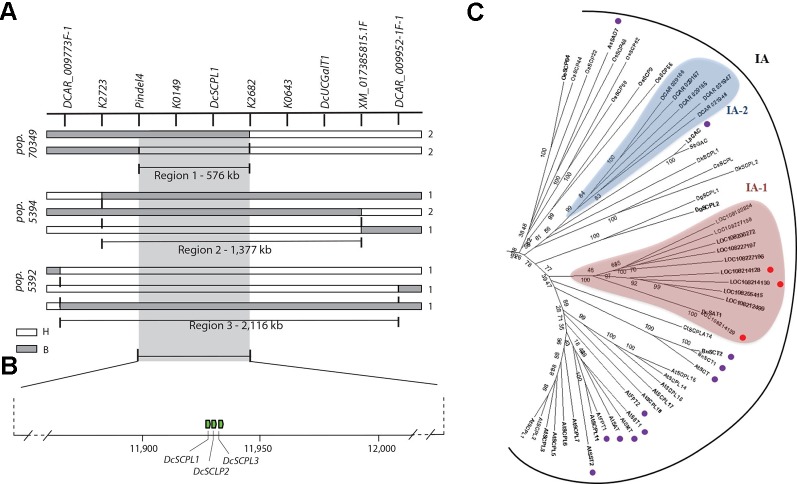
Fine mapping summary and phylogenetic analysis of candidate genes controlling the Raa1 locus. (A) Haplotypes delimiting the genomic regions controlling the Raa1 locus in population 70349 (region 1), 5394 (region 2), and 5392 (regions 3). Genotyping scores to draw this figure were extracted from
Supplementary Table S11
. The white bars indicate the heterozygous haplotypes (H = Aa) and the gray bars indicate the homozygous recessive haplotypes (B = aa). Region 1 represent the genomic sequence delimited by the nearest markers flanking the Raa1 locus across regions 1–3. Numbers on the right side of each bar represent the number of recombinant genotypes for each haplotype. (B) Schematic representation of carrot chromosome 3 containing regions 1–3 and three SCPL acyltransferase genes (green boxes). The scheme was drawn to scale. (C) SCPL phylogenetic clade IA extracted from the neighbor-joining phylogenetic analysis of SCP and SCPL proteins presented in
Supplementary Figure S5
. Bootstrap values are percentage from 1,000 replicates. The scale bar indicates 0.1 substitutions per site. Clades are labeled according to Fraser et al. (2005). Two clusters of carrot SCPL-ATs are highlighted, IA-1 (red) and IA-2 (blue). Protein sequences and complementary information are presented in
Supplementary Tables S4
 and
S5
. Red circles indicate SCPL genes located within the Raa1 locus. Purple circles indicate the following functionally characterized SCPL-ATs. Six SCPL-ATs from Arabidopsis thaliana: AtSCT, sinapoylglucose:choline sinapoyltransferase; AtSMT, sinapoylglucose:malate sinapoyltransferase; AtSAT, sinapoylglucose:anthocyanin sinapoyltransferase; AtSST1 and AtSST2, sinapoylglucose:sinapoylglucose sinapoyltransferases; AtFPT1 and AtFPT2, flavonol-phenylacyltransferases. BnSCT1 and BnSCT2, from Brassica napus. LpGAC, glucose acyltransferase from Lycopersicon pennellii. AsSAD7, sinapoylglucose:sinapoylglucose sinapoyltransferase from Avena sativa.